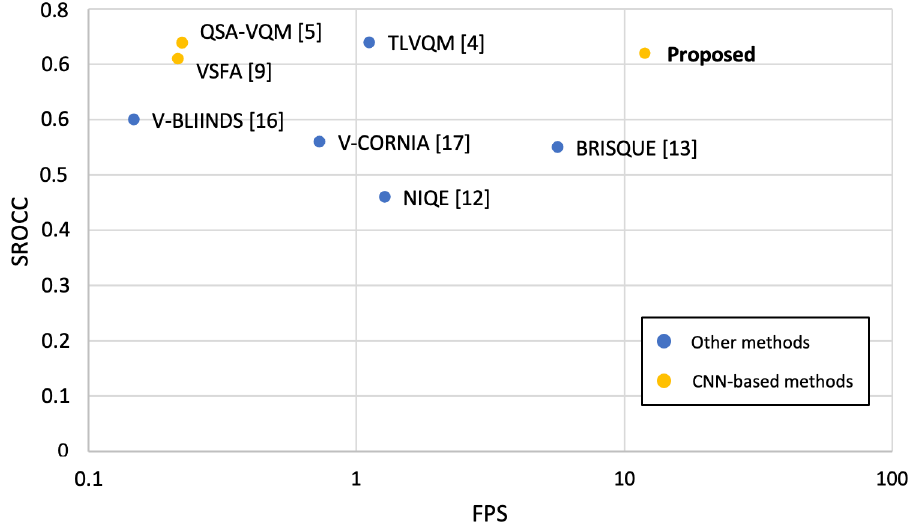
Figure 1. Speed vs. mean Spearman’s Rank-order Correlation Coefficient (SROCC) computed across 100 train-test combinations on LIVE-Qualcomm videos (resolution at 1080p). Speed is measured by running methods in